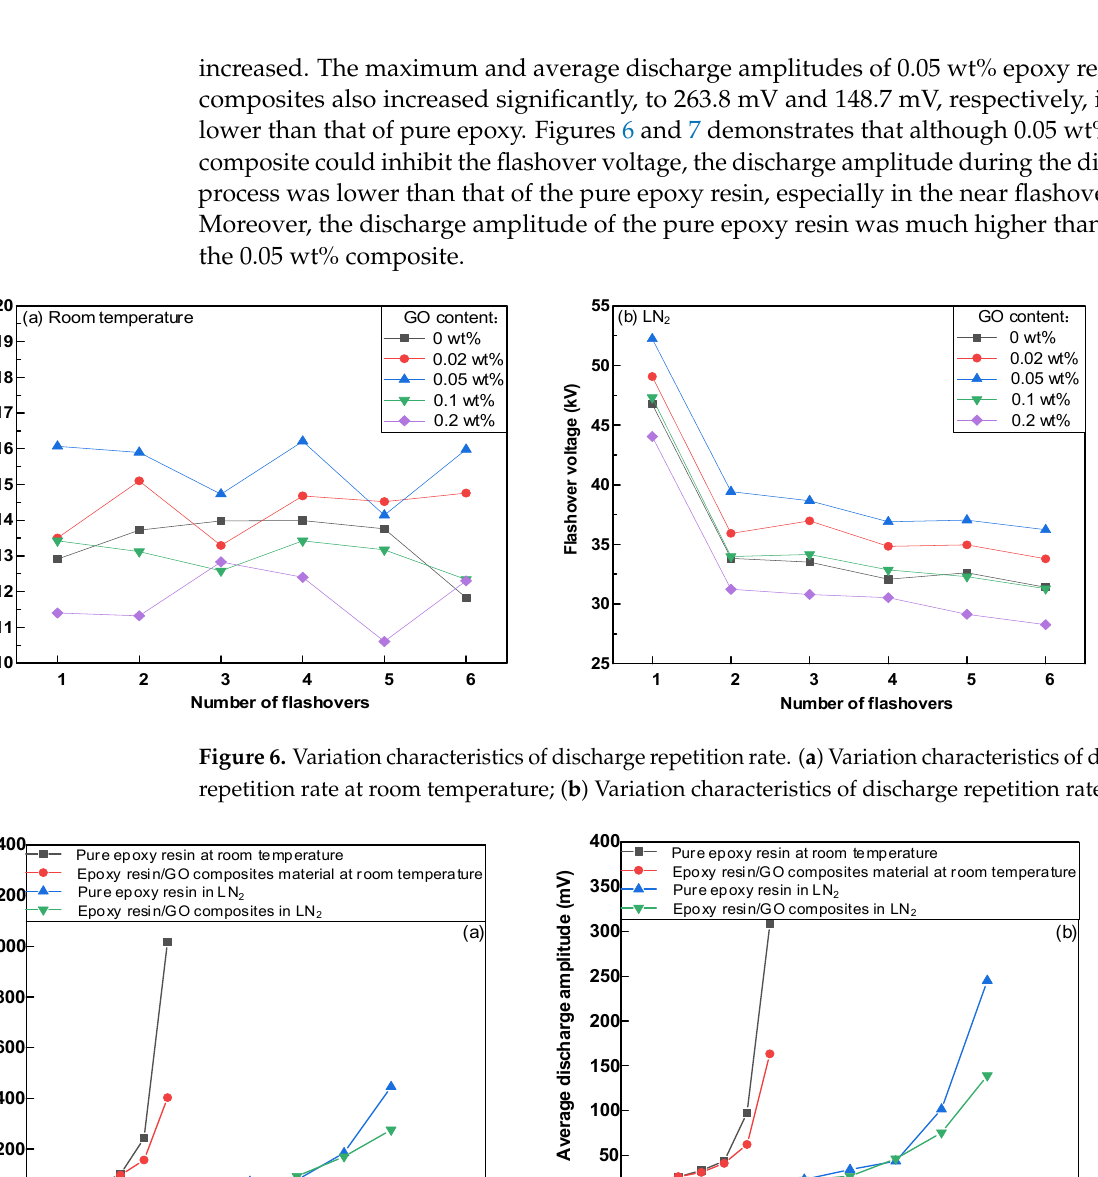
regulated by nano GO was weaker than that of pure epoxy resin. When the applied volt-